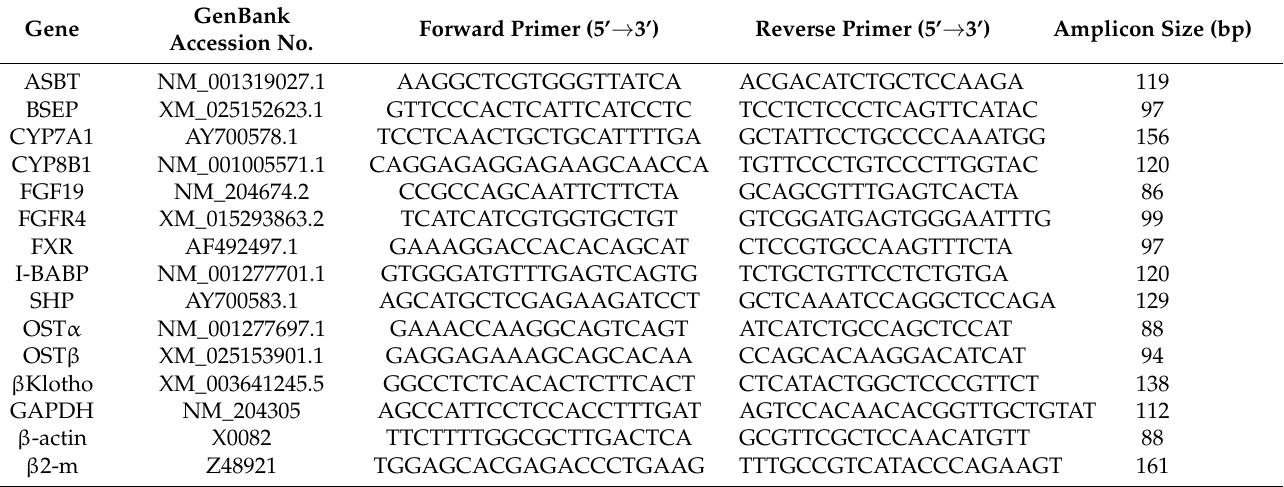
Table 1. Primers for the analysis of mRNA levels using quantitative real-time